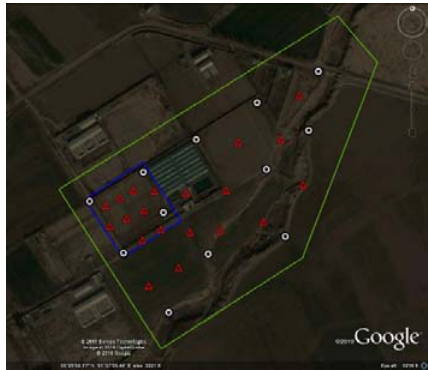
Figure 5. Study area (green line), selected area for lever arm calibration (blue line), ground control points (white circle) and check points (red triangle).